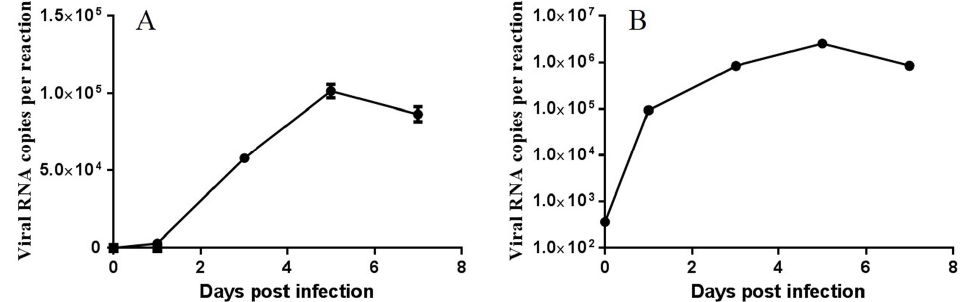
Figure 1. Characterization of peste des petits ruminants (PPR) vaccine virus inoculation in sheep peripheral blood lymphocyte (PBMC) and sheep testicular (ST) cells. ( A ) RT-qPCR analysis of N gene in PPR vaccine virus-inoculated sheep PBMC; ( B ) RT-qPCR analysis of N gene in PPR vaccine virus-inoculated ST cells.